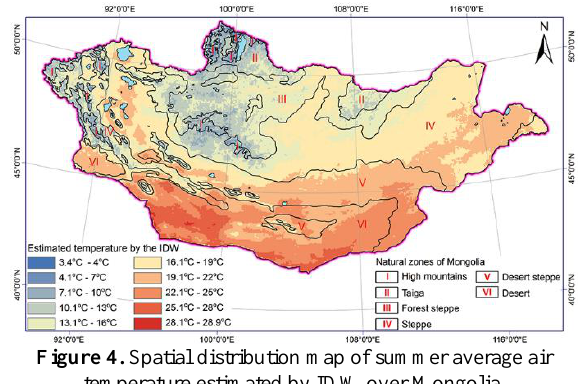
Figure 4. Spatial distribution map of summer average air temperature estimated by IDW over